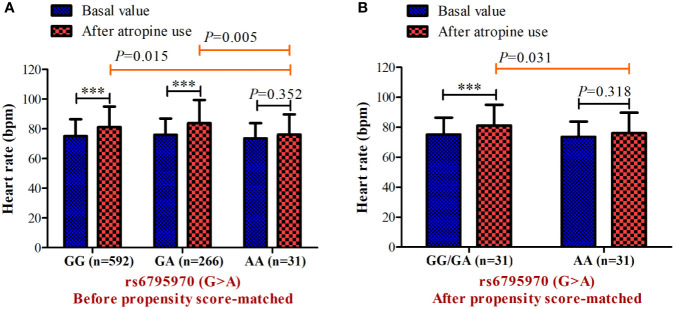
Heart rate before and after atropine use for patients with different genotypes of s6795970 in non-matched cohort (A) and matched cohort (B). ***P < 0.001 compared to basal value.